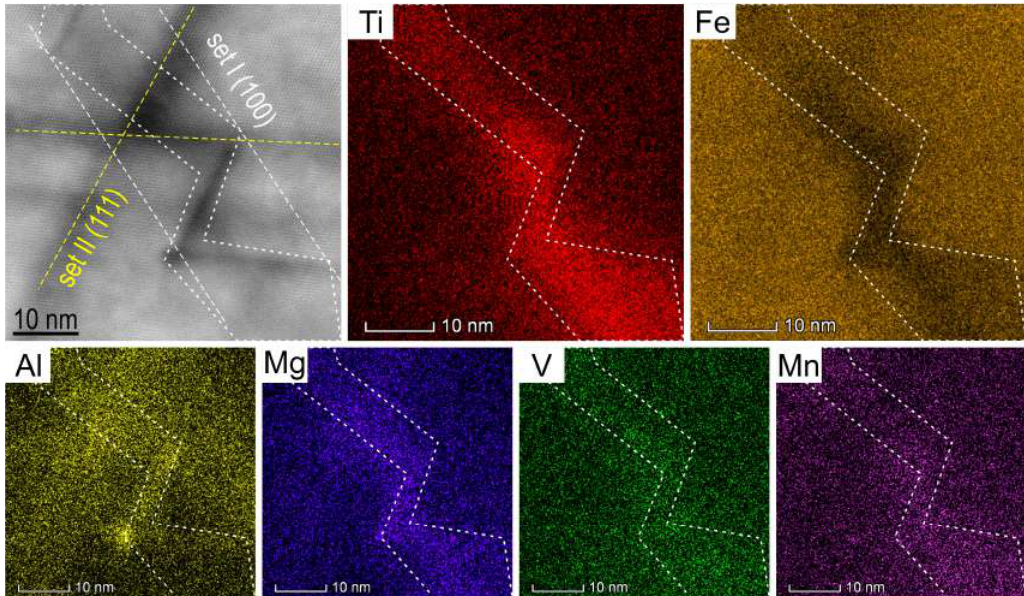
Figure 9. HAADF STEM image (top left) and STEM EDS maps showing compositional variation in areas with crosscutting patterns marked as set II {111} lamellae across a set I {100} band. Both sets comprise ilmenite + spinel minerals. Titanium correlates positively with Al, Mg, V, and Mn, and negatively with Fe. Of all the elements, Al shows the most pronounced correlation with the textures and also shows a spot of high concentration at the edge of {111} directions.